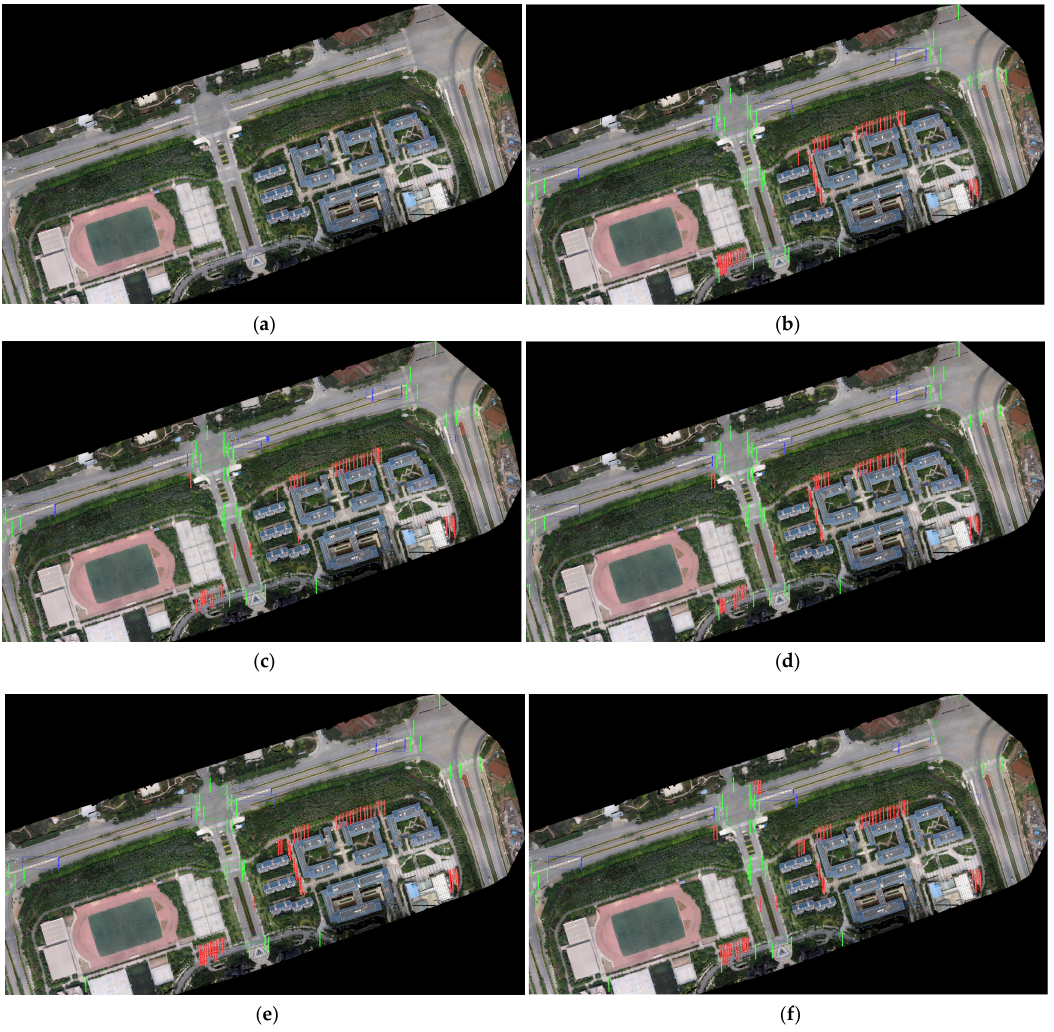
Figure 12. Predicted results of the ablation experiment for a large and complex scenario: ( a ) detec- tion of the original image; ( b ) YOLOv5; ( c ) YOLOv5 with SPPF; ( d ) YOLOv5 with K-means++; ( e )